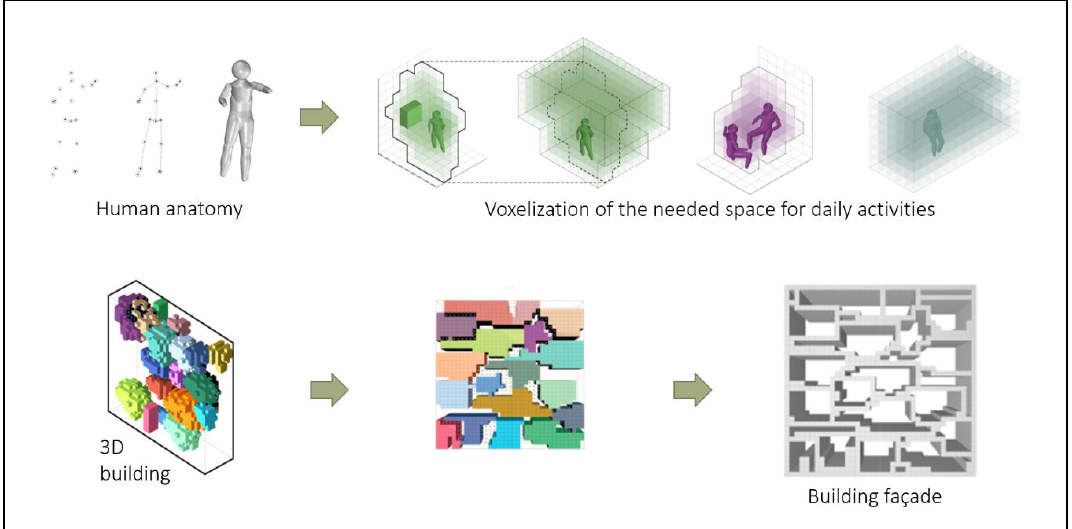
Figure 2. Representation of the methodology adopted by the On-The-Go project to estimate the volumetric size of the living space within a building.